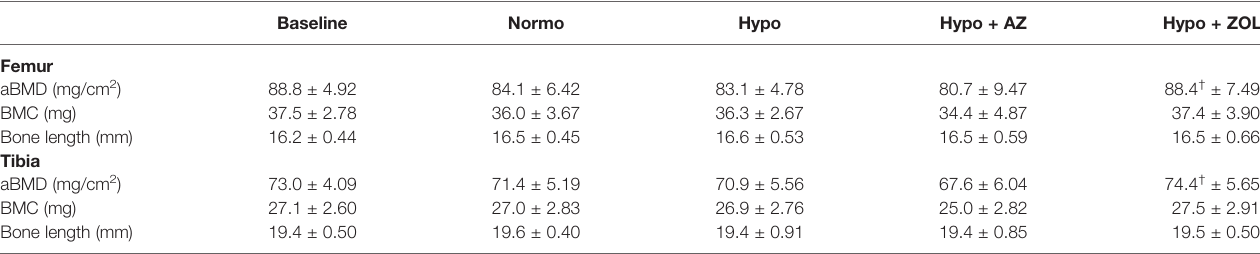
TABLE 2 | Whole femoral and tibial areal bone mineral density (aBMD), bone mineral content (BMC), and bone length of mice housed at normobaric ambient pressure (Normo) or hypobaric pressure (Hypo) at 500 mbar for four weeks and treated with acetazolamide (AZ) or zoledronate (ZOL). All data were analyzed using a one-way ANOVA, except for femoral BMC and tibial length where the non-parametric Kruskal – Wallis test were used.